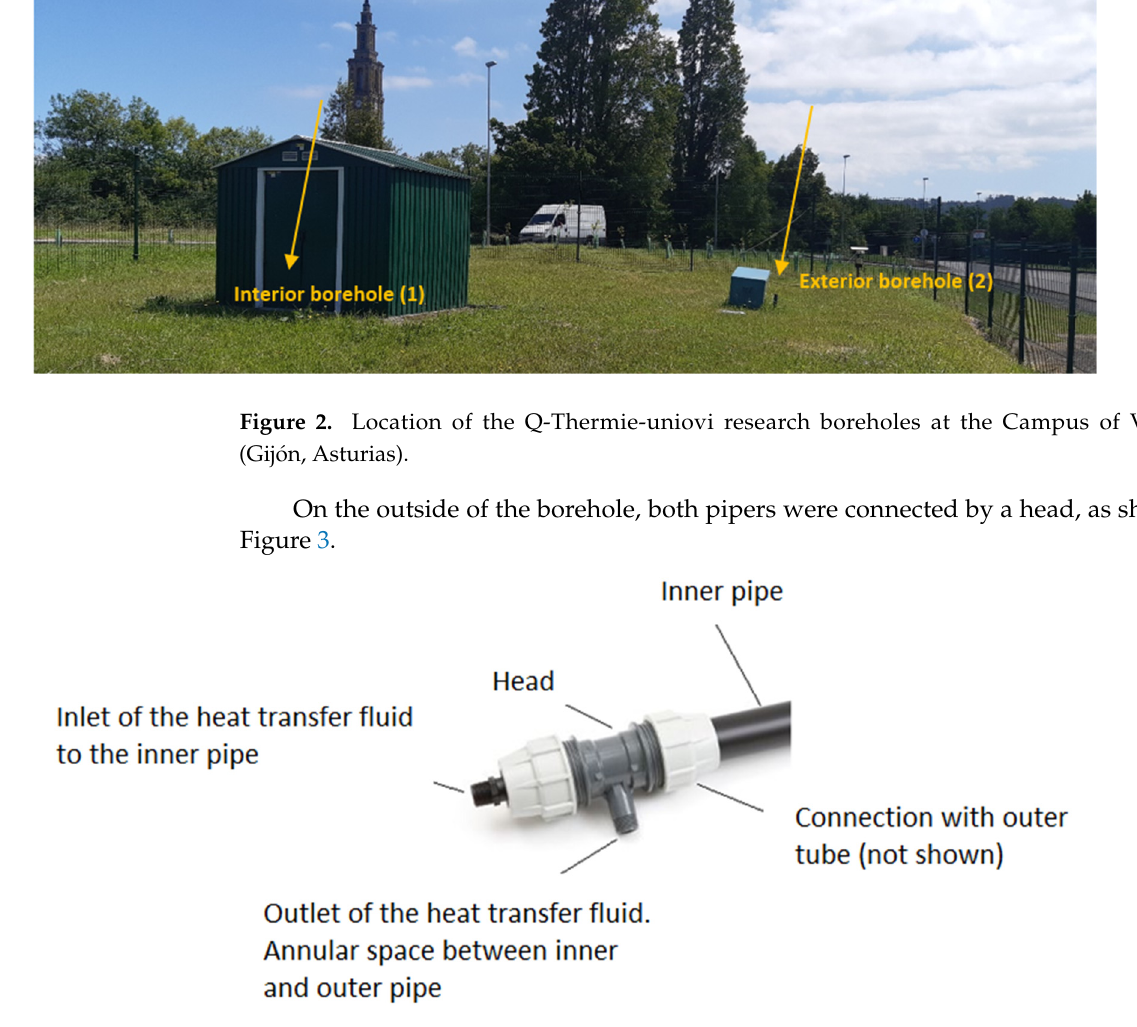
Figure 2. Location of the Q-Thermie-uniovi research boreholes at the Campus of Viesques (Gijón, Asturias).